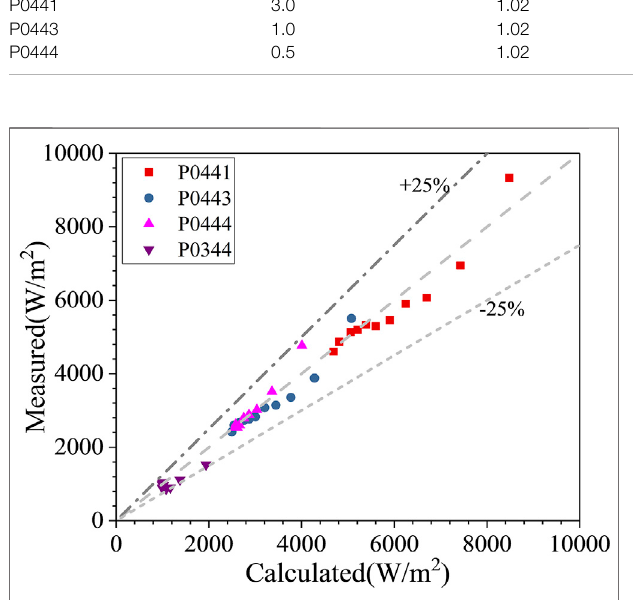
FIGURE 3 | Prediction results of original model compared with COPAIN experimental data.